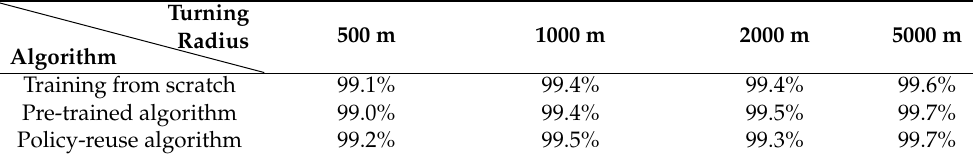
Table 5. Success rate in curved-motion destination